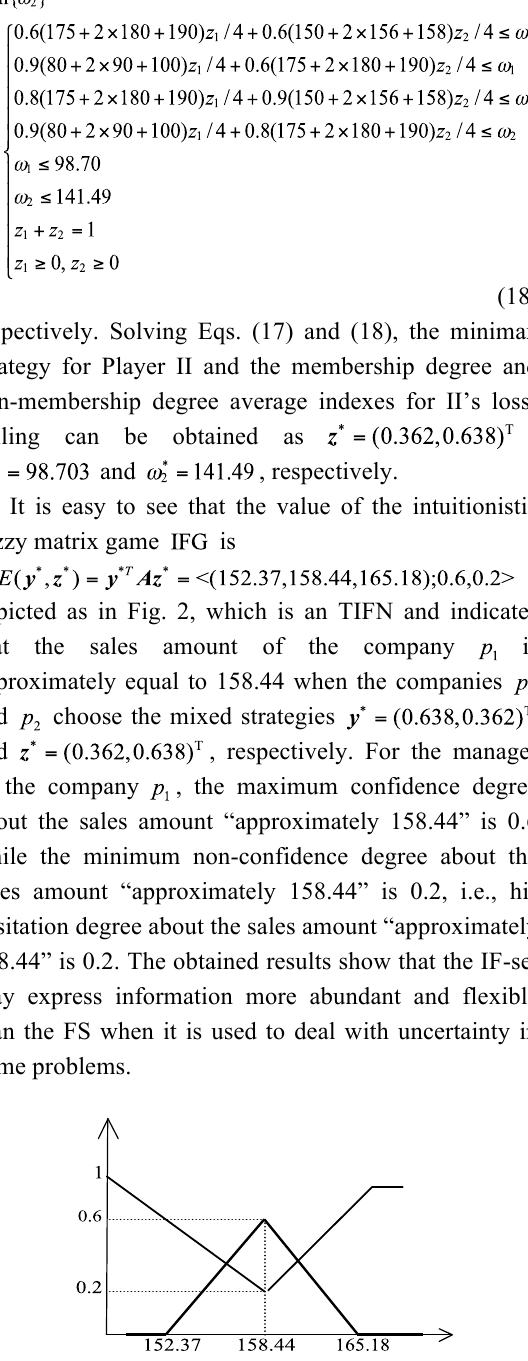
Fig. 2. The solution of the intuitionistic fuzzy matrix game for the market share